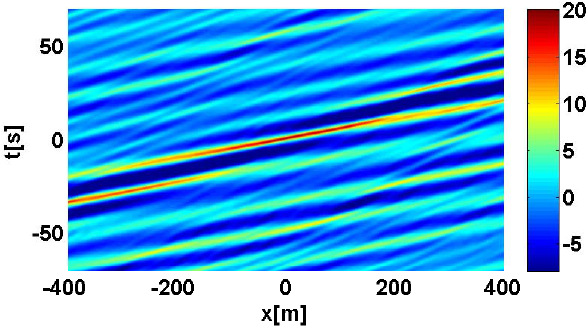
Fig. 14. The density of the elevation of Draupner wave using initial signal at X synth =− 400m.